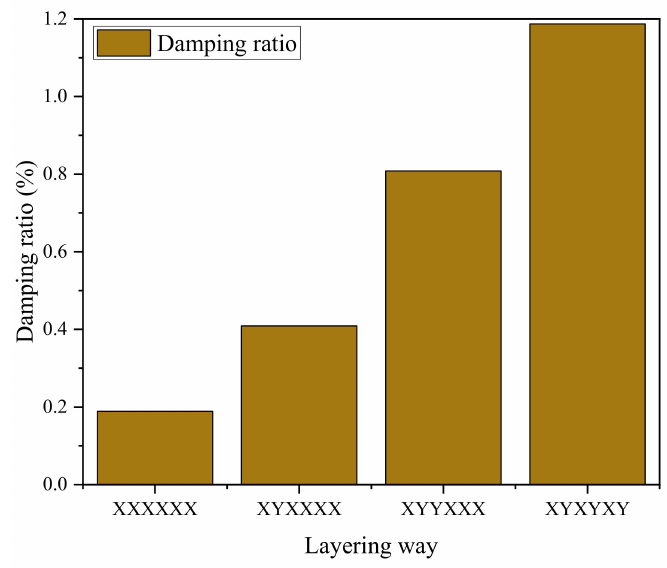
Figure 9. Damping ratios of different layering ways.